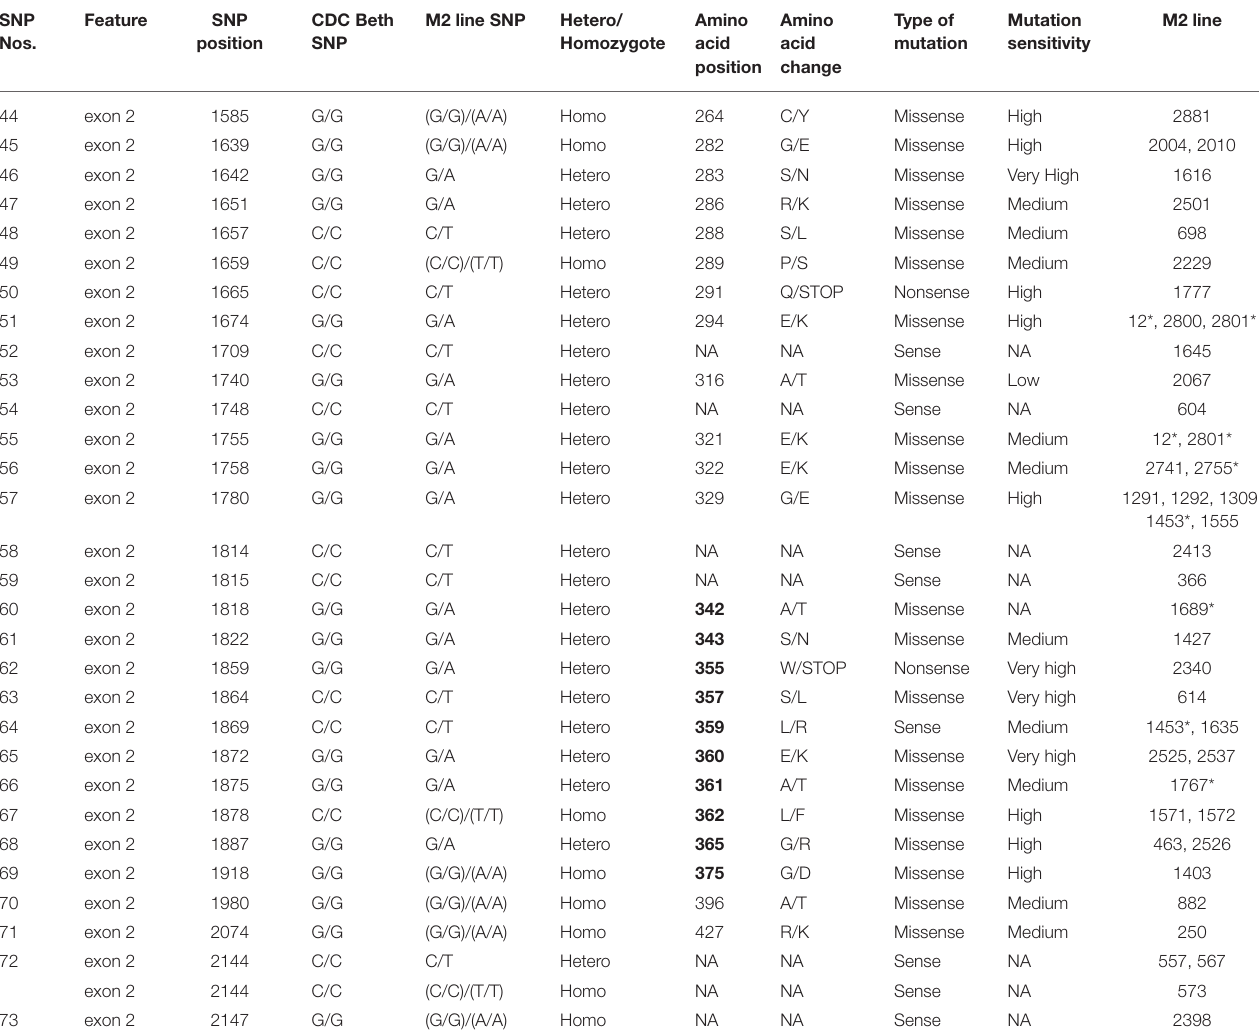
NA, Not applicable for no amino acid change; * Lines with mutations at two loci. Heterozygous SNP (single strand nucleotide change) and homozygous SNP (change of double strand nucleotide as marked in bracket) at each position are indicated and separated by a “/”. Positions of amino acids changed by EMS mutagenesis within the PSPG motif are indicated in